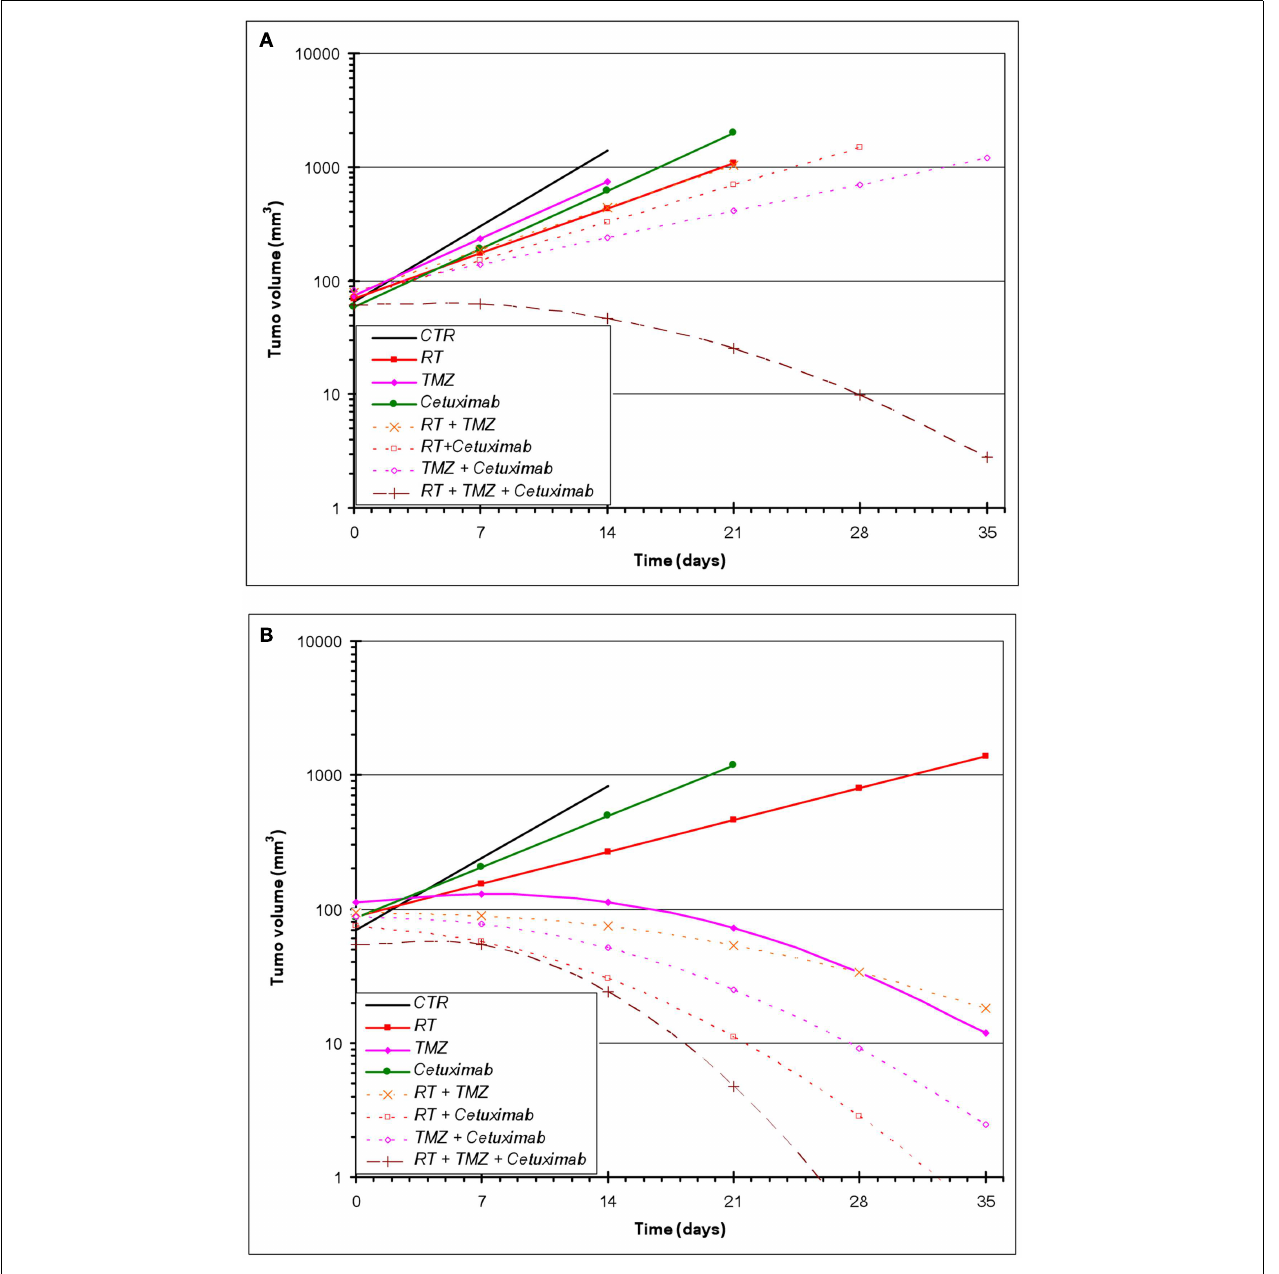
in Section “Materials and Methods,” was used to model tumor volume as a function of time and treatment. Each treatment group consisted of 10–15